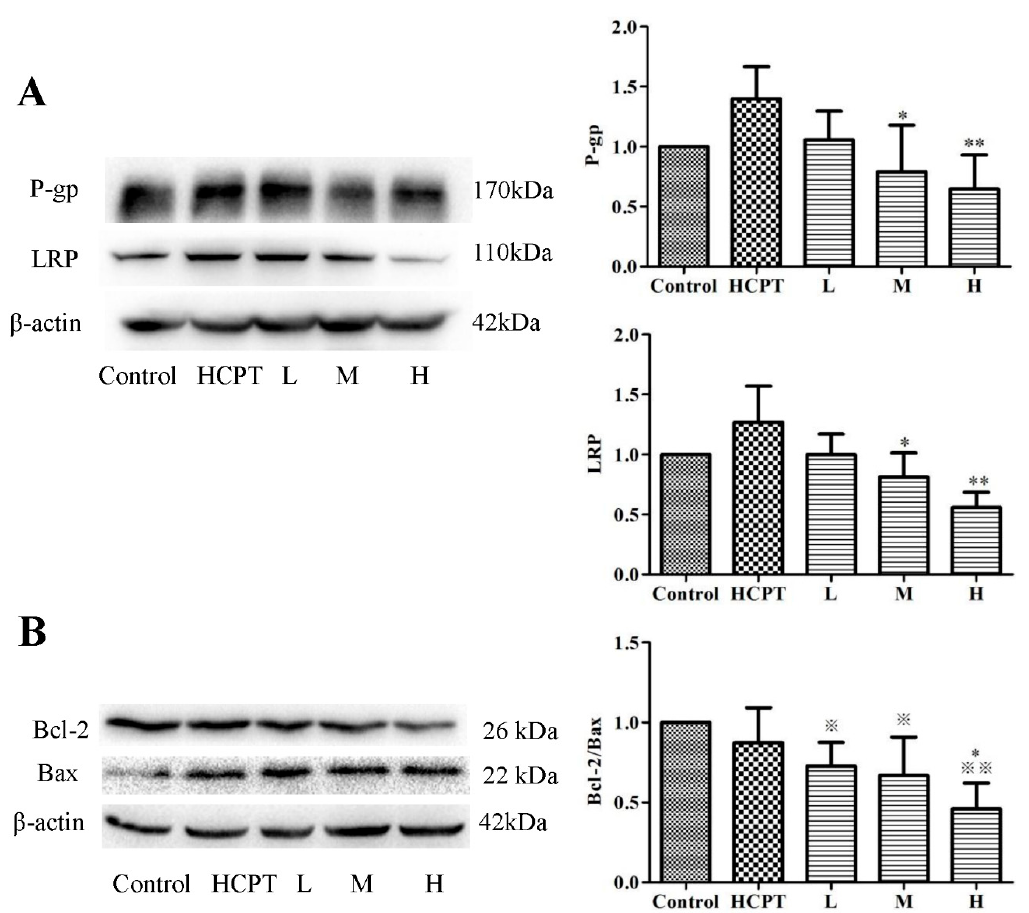
Figure 4. Effect of combination of JGGC on the protein express of LRP and P-gp ( A ) and the protein express of Bcl-2 and Bax ( B ). Data are shown as mean ± SD, n = 3. ※ p < 0.05, ※※ p < 0.01 vs. control; * p < 0.05, ** p < 0.01, vs. HCPT.